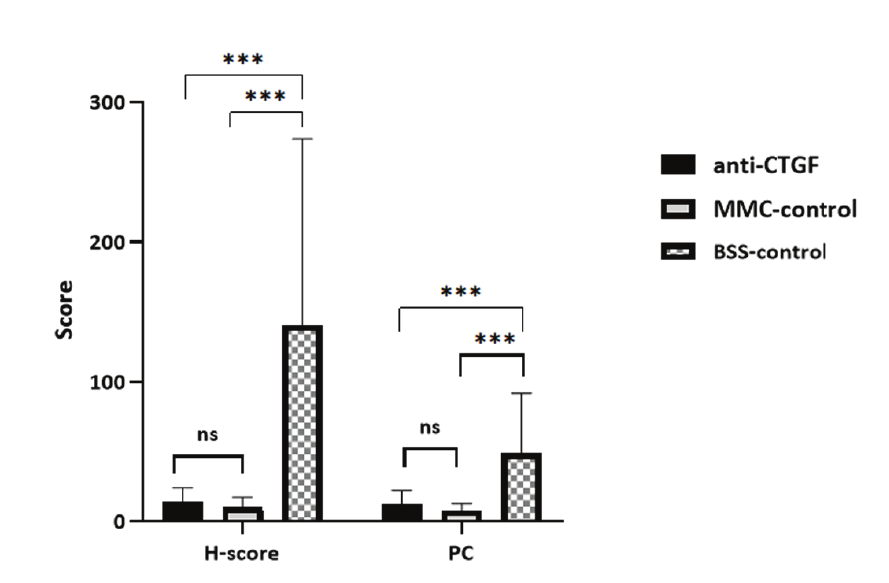
Figure 4. The black bar represents the mean of H-score in each group. (H-SCORE = I × PC; I, the grade of staining; and PC, the percentage of immune stained cells). PC was calculated as the ratio of green, fluorescent cells with DAPI-stained nuclei to all DAPI-stained nuclei. Significance at < 0.05, < 0.01, and < 0.001 are indicated in figures by *, **, and ***, respectively.